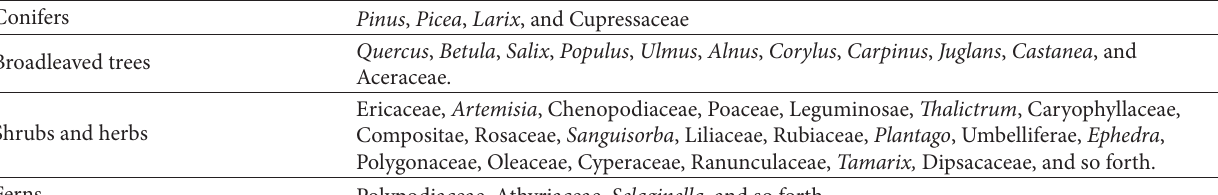
Table 2: Pollen types in the Beihong Section.